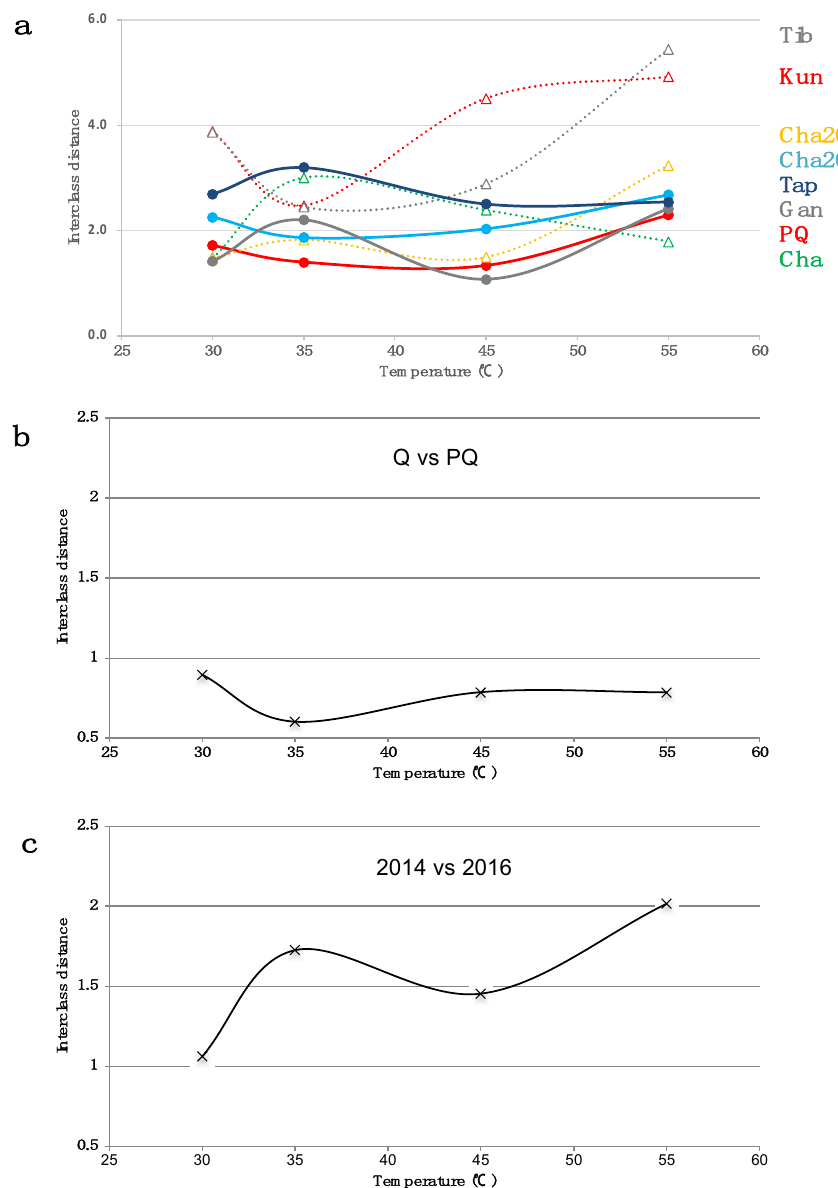
Figure 5. SIMCA interclass distance plotted as a function of temperature unravel information in the natural, processed and aged water. ( a ) The interclass distance of the eight different waters compared to pure water (Q). Solid lines with circular marks, PQ: red, Cha2016: light blue, Gan: gray and Tap: dark blue and dotted lines with triangular marks, Cha: green, Cha2014: yellow, Tib: gray and Kun: red. ( b ) The interclass distance between processed water and non-processed water (Q vs. PQ) as a function of temperature. ( c ) The interclass distance between aged and freshly produced processed waters (Cha2014 vs. 2016) as a function of temperature. Spectral data are transformed using the SNV, average Q at the given temperature is subtracted and, finally, the spectra are smoothed using Savitzky Golay filter (25 pts).